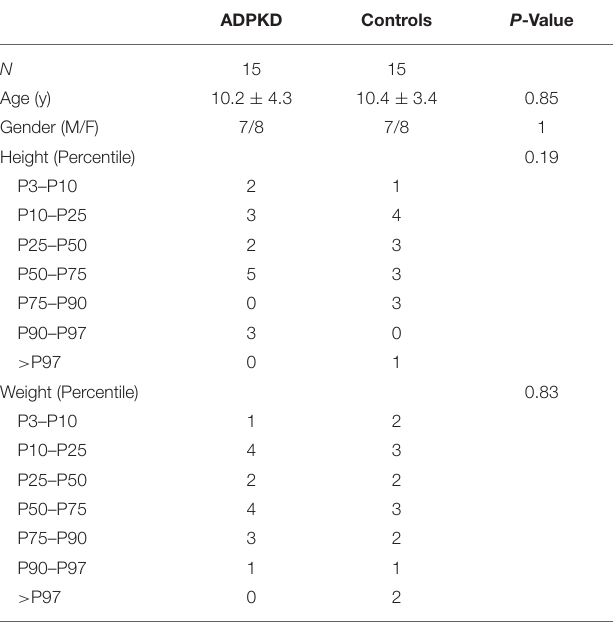
TABLE 1 | Patient and control group characteristics. ADPKD Controls P